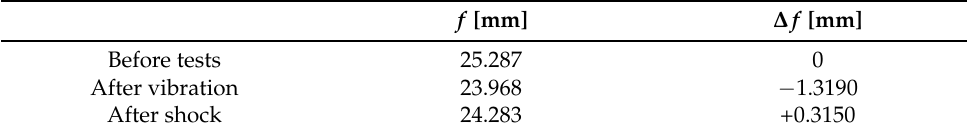
Table 8. Focal length variation due to launch environment dynamics.